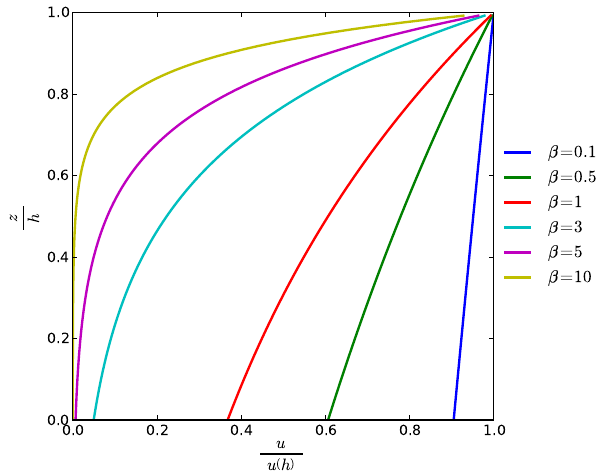
Figure 4. Wind velocity profiles as predicted by Eq. (16) for various values of the attenuation coefficient β